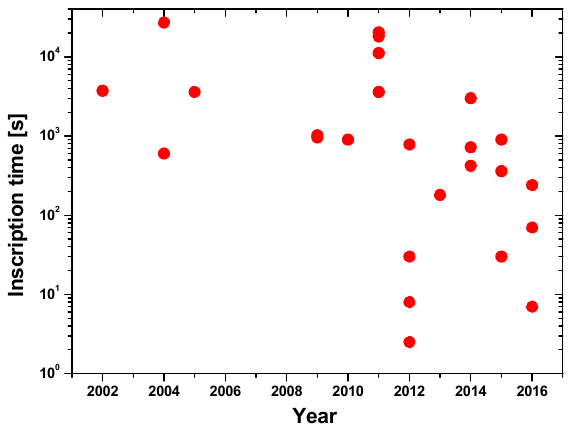
Figure 2. Historical evolution of inscription time of POF Bragg gratings.